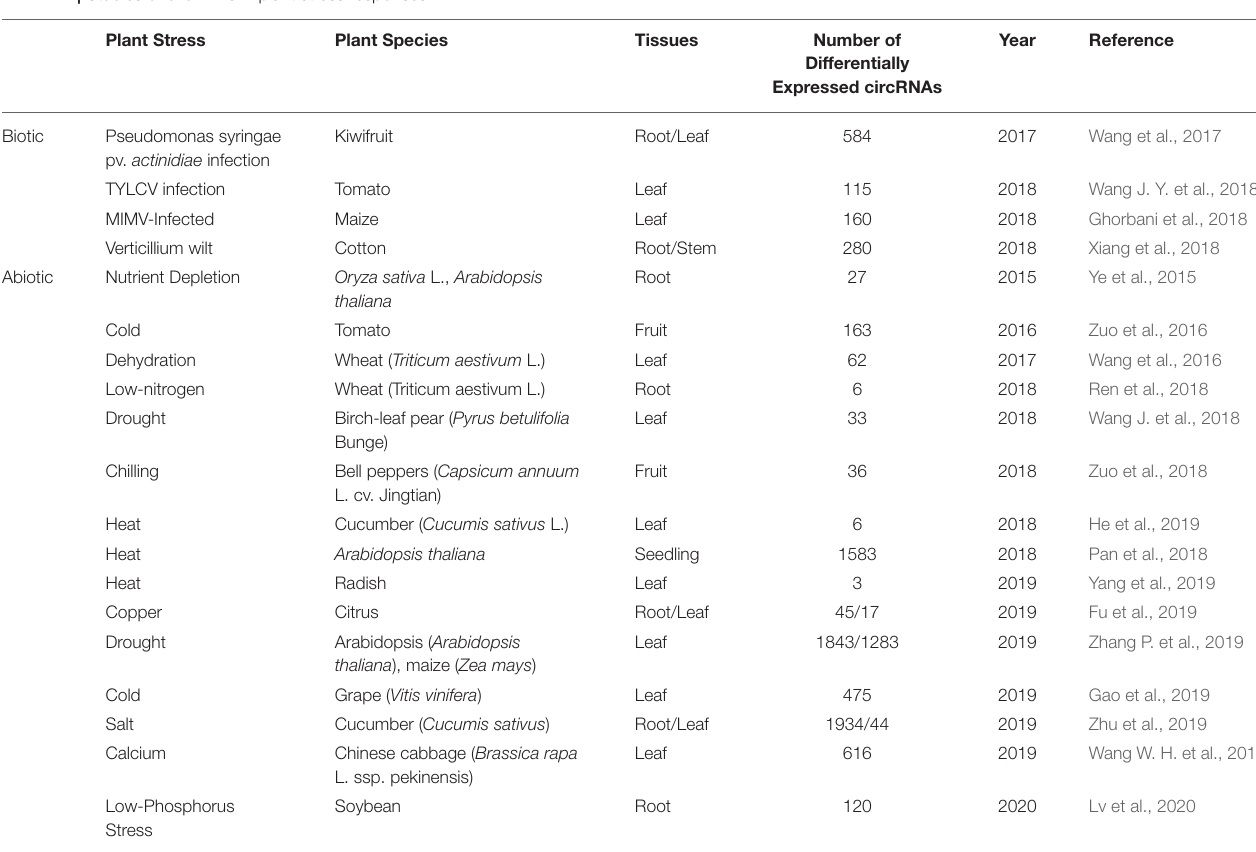
TABLE 2 | Studies of circRNAs in plant stress